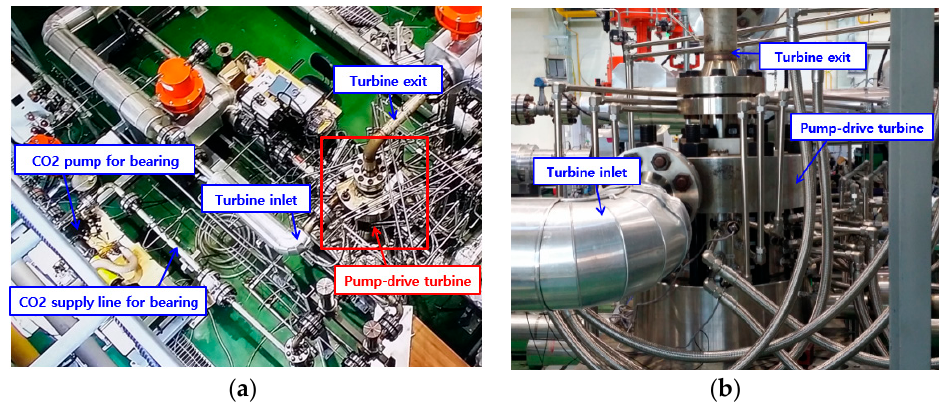
Figure 12. Test loop for pump-drive turbine. ( a ) Test loop for supercritical CO 2 cycle; ( b ) Pump-drive turbine module.